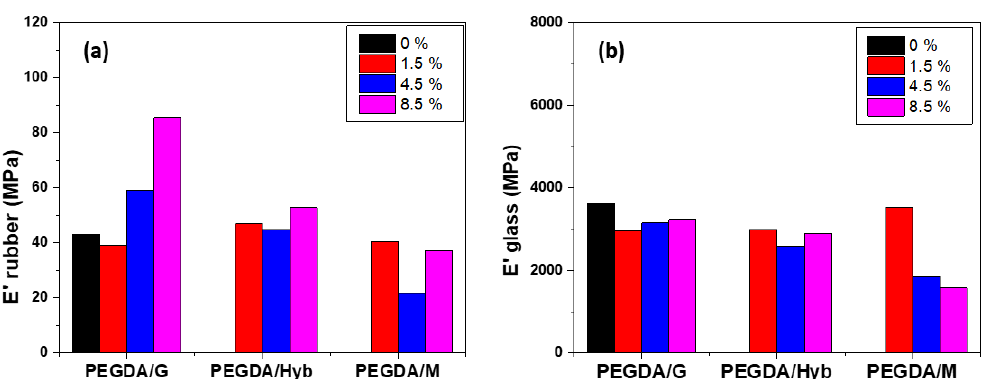
Figure 4. Storage modulus tensile at the rubbery ( a ) and the glassy state ( b ) obtained by DMA for neat and reinforced samples in different nanofiller’s percentage.